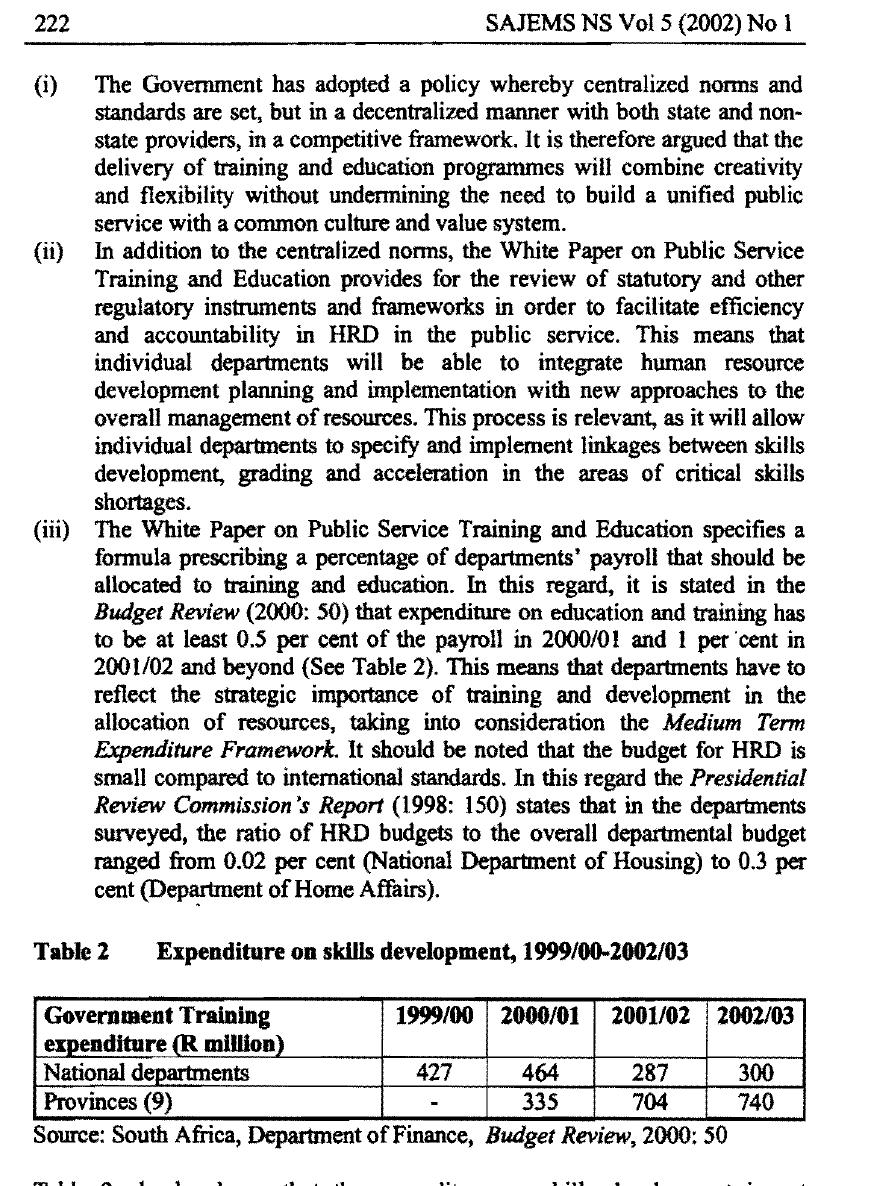
Expenditure on sldUs development, 1999/00-1001/03 Government